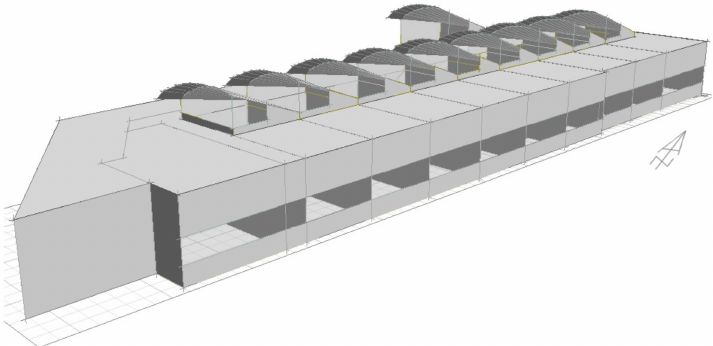
Figure 4. A sketch of the final proposal for skylights.